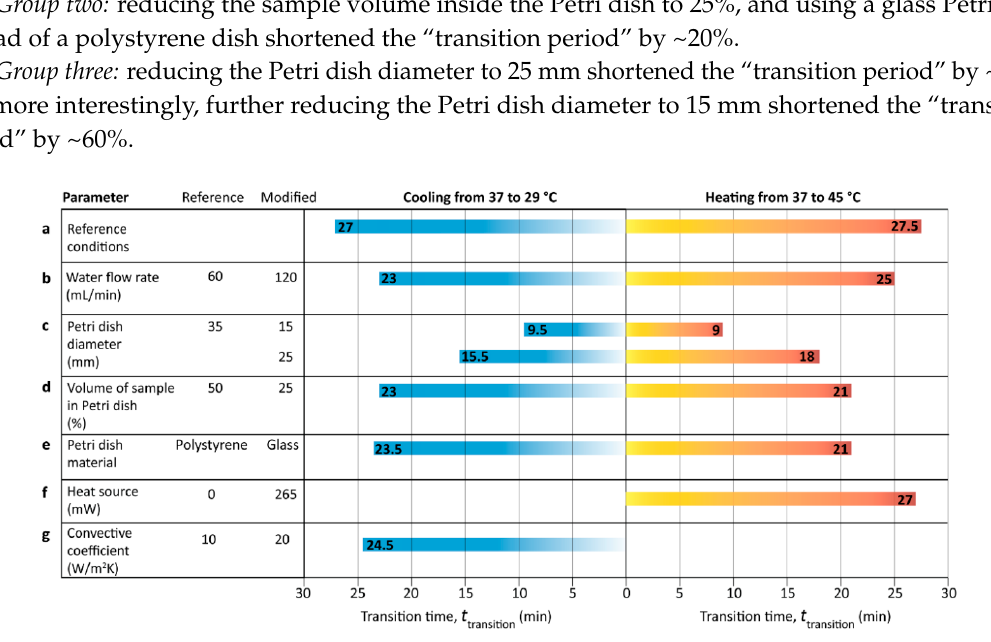
Figure 8. Comparison of the “transition period” for heating (37 to 45 °C) and cooling (37 to 29 °C) modes of the sample using different strategies, obtained by numerical simulations: ( a ) reference conditions. ( b ) Increased flow rate of water recirculating through the water jacket. ( c ) Decreased diameter of Petri dish. ( d ) Reduced sample volume stored in the Petri dish. ( e ) Increased thermal conductivity of the Petri dish by replacing polystyrene with glass. ( f ) Placing a heating element underneath the Petri dish. ( g ) Increasing the localized convection coefficient below the Petri